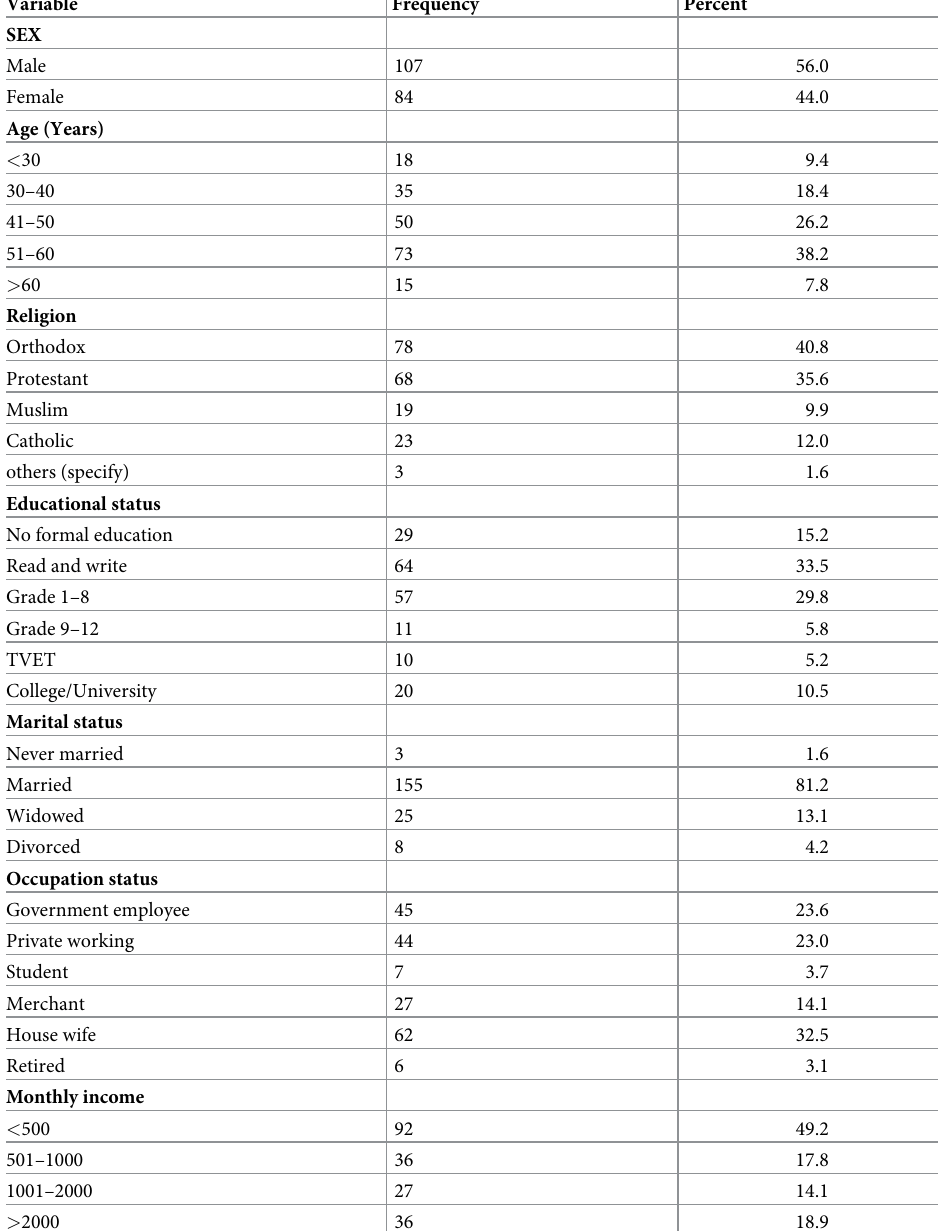
Table 1. Socio-demographic and economic characteristics of T2DM patients who attend the medical referral clin- ics for treatment and follow up at DURH, 2017. Variable Frequency